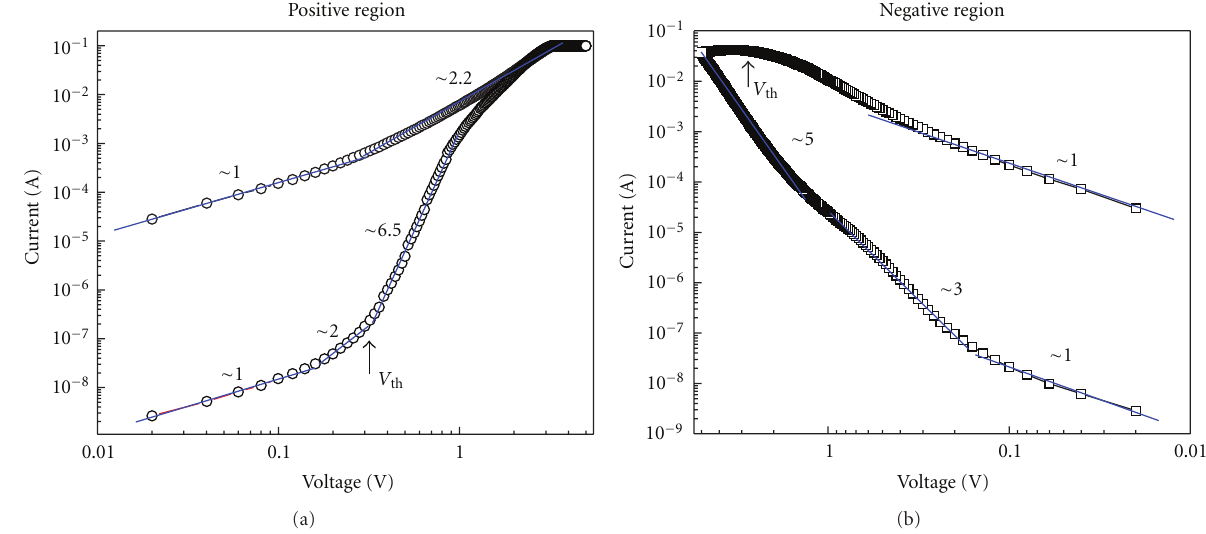
Figure 6: (Color online) I-V characteristics of switching memory cell in (a) positive bias region and (b) negative bias regions plotted in log-log